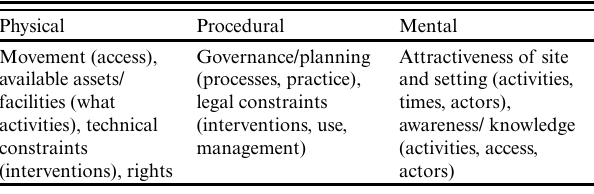
Table 2. Types of filter effects demonstrated in the six ENABLE